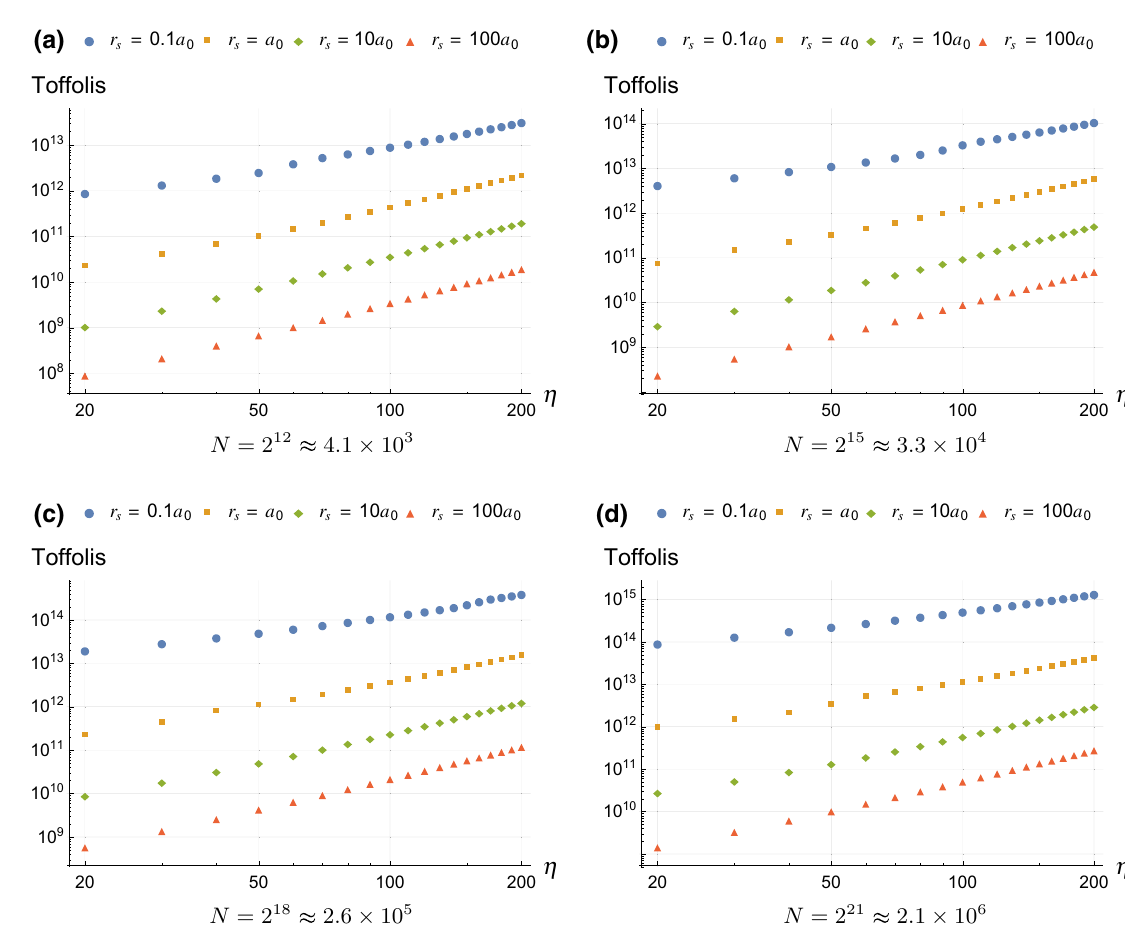
FIG. 3. Toffoli count of qubitization as a function of η using the improved techniques of this paper. In contrast to Fig. 1, we plot these costs for fixed values of the Wigner-Seitz radius r s to give a sense of the scaling when η increases proportionally to (cid:10) (as would be the case when growing condensed phase simulations towards their thermodynamic limit). Thus, we expect these plots to be representative of costs when simulating periodic materials. We see that the qubitization-based algorithm performs better across all regimes studied to compared to the interaction-picture-based algorithm (Fig.